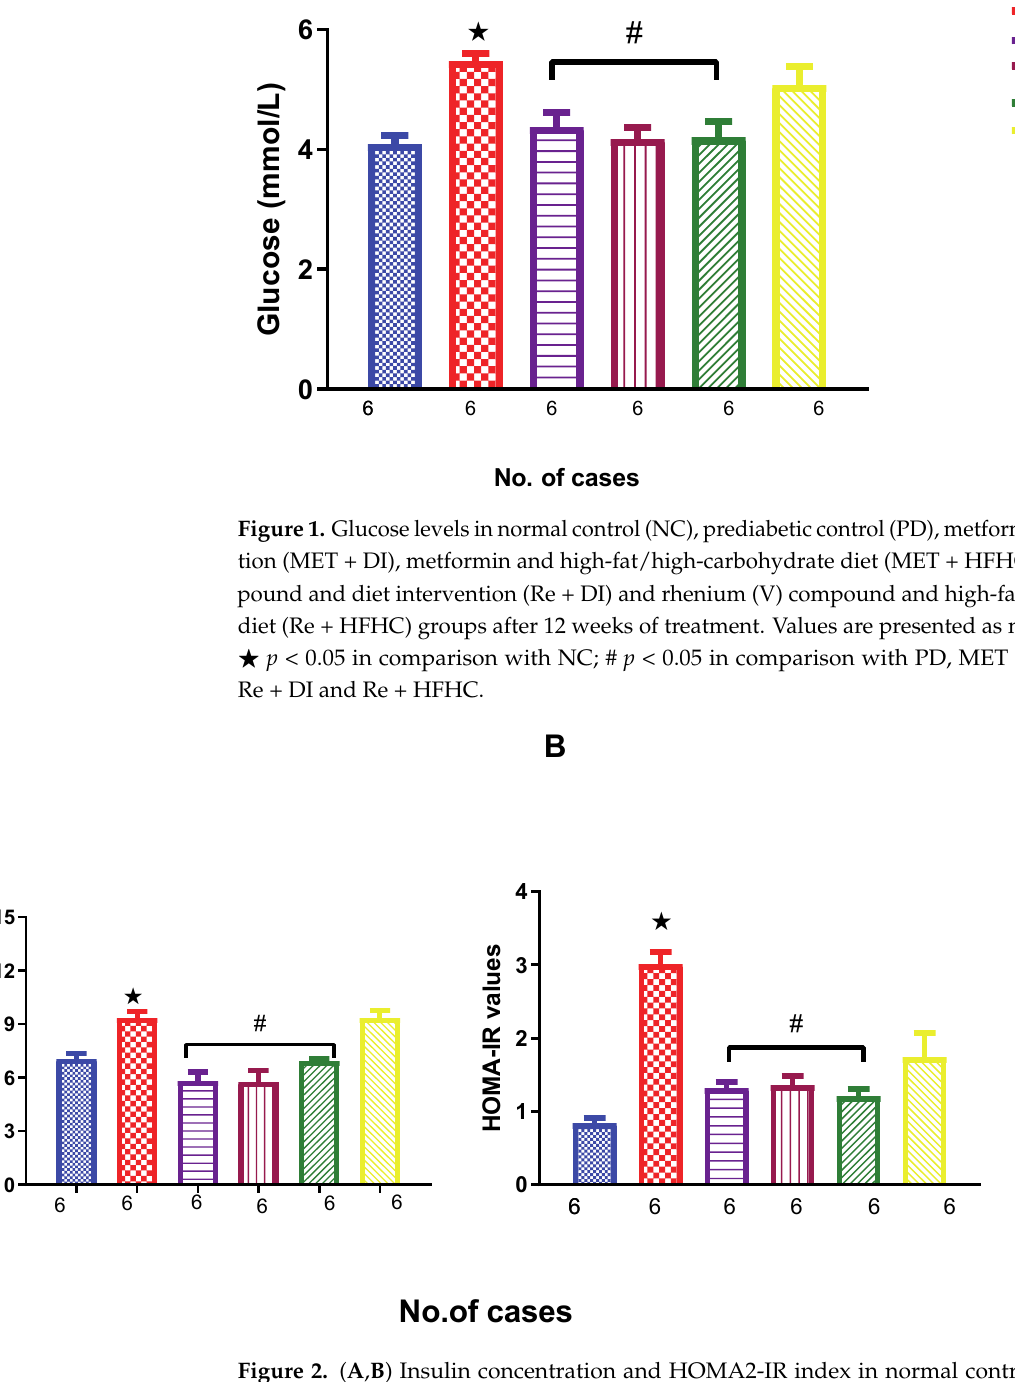
Figure 2. ( A , B ) Insulin concentration and HOMA2-IR index in normal control (NC), prediabetic control (PD), metformin and diet intervention (MET + DI), metformin and high-fat/high-carbohydrate diet (MET + HFHC), rhenium (V) compound and diet intervention (Re + DI) and rhenium (V) compound and high-fat/high-carbohydrate diet (Re + HFHC) groups after 12 weeks of treatment. Values are presented as means ± SEM (n = 6). (cid:70) p < 0.05 in comparison with NC; # p < 0.05 in comparison with PD, MET + DI, MET + HFHC, Re + DI and Re +